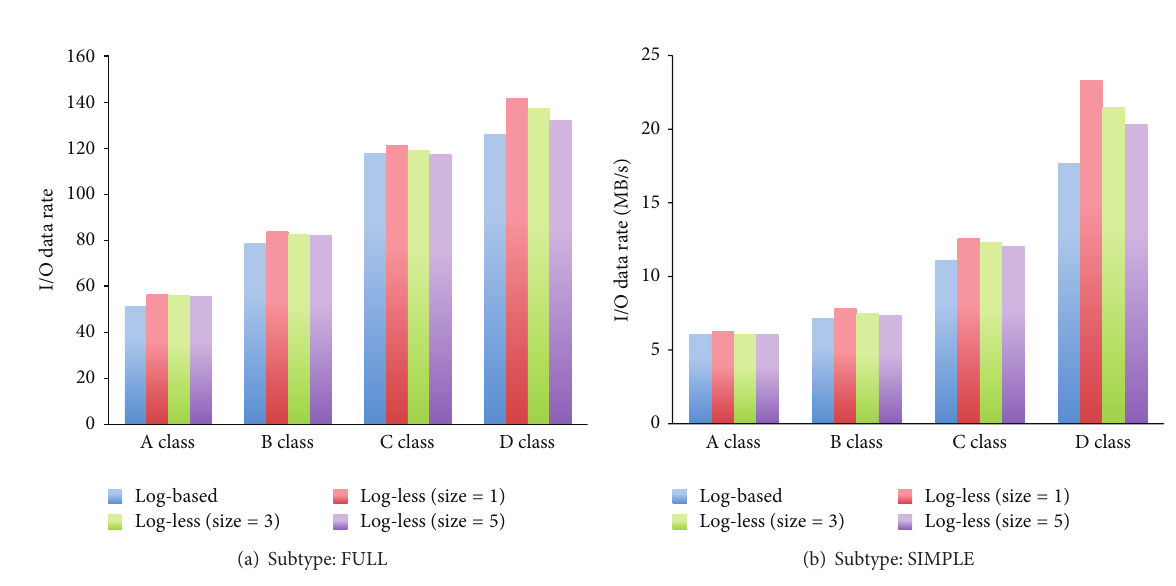
Figure 5: Metadata performance: creation operation.